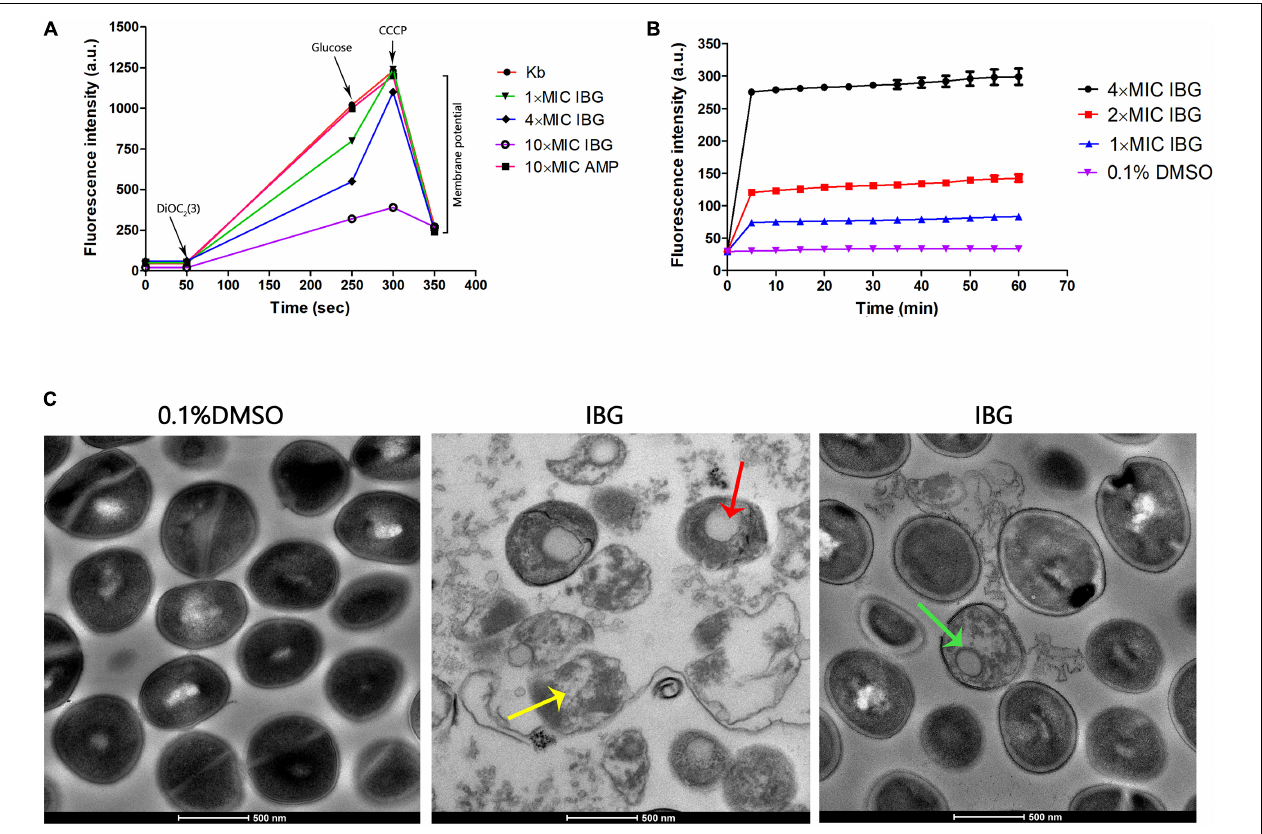
FIGURE 2 | IBG exerts its antibacterial action on the cell membrane of S. aureus . (A) IBG dissipates the membrane potential of S. aureus ATCC 29213. P values were determined using a non-parametric one-way ANOVA. P values of (* ≤ 0.05) (** P ≤ 0.01) are considered as significant. (B) Uptake of SYTOX Green by exponential-phase S. aureus ATCC 29213 cells treated with IBG. (C) Transmission electron micrographs of S. aureus cells in response to IBG. Scale bars, 500 nm. These arrows indicate damage to the cell membrane by IBG. Kb, S. aureus ATCC 29213 control cell treated with 0.1% DMSO.